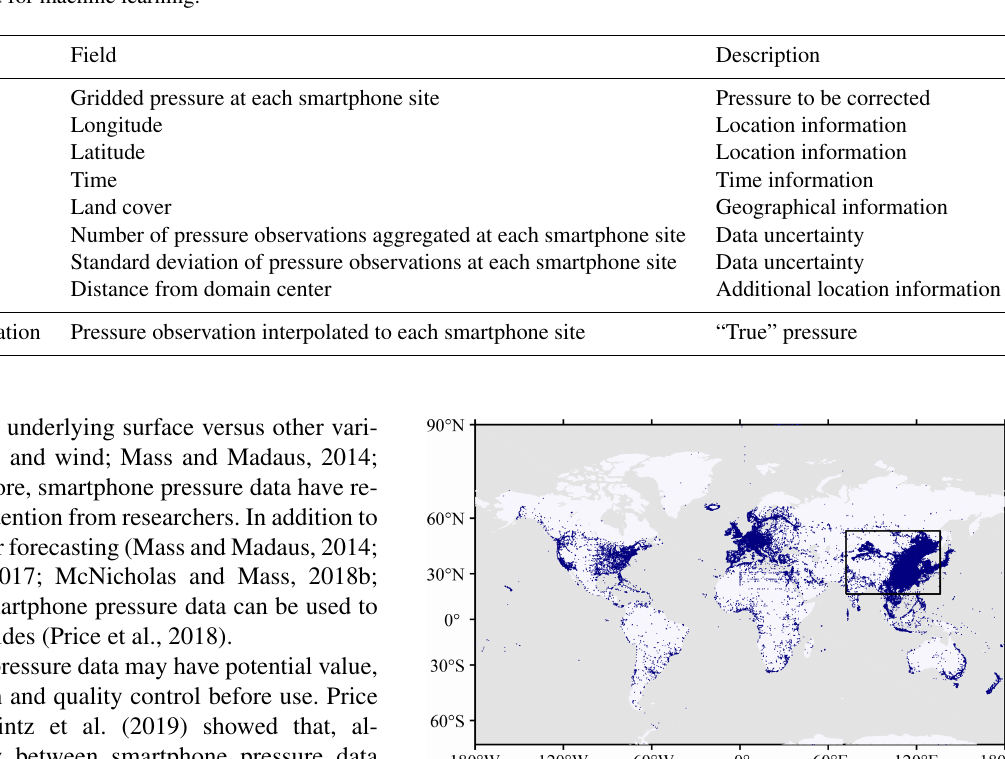
Figure 1. The workflow for smartphone pressure data quality control and preprocessing. See text for details. Table 1. Parameters used for machine learning.